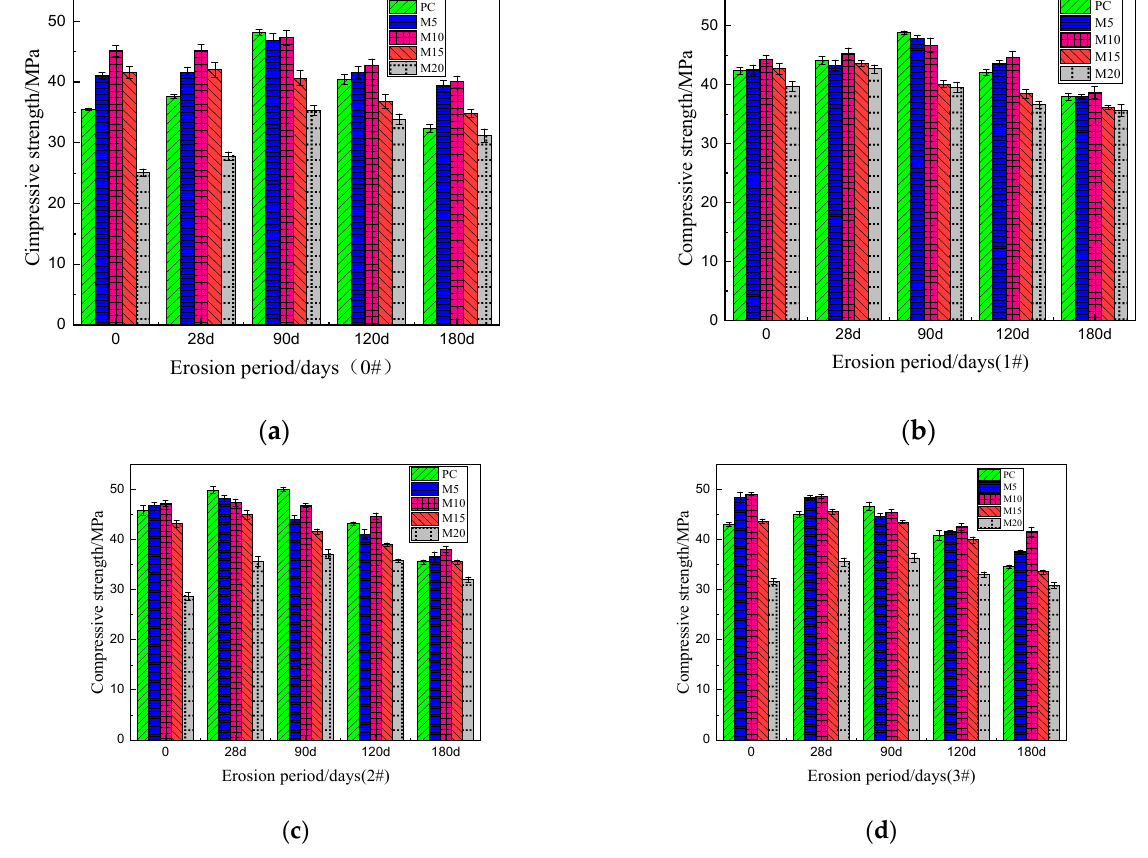
Figure 4. Compressive strength of cement mortar after a different erosion period under different curing methods; ( a ) 0#, ( b ) 1#, ( c ) 2#, ( d ) 3#.